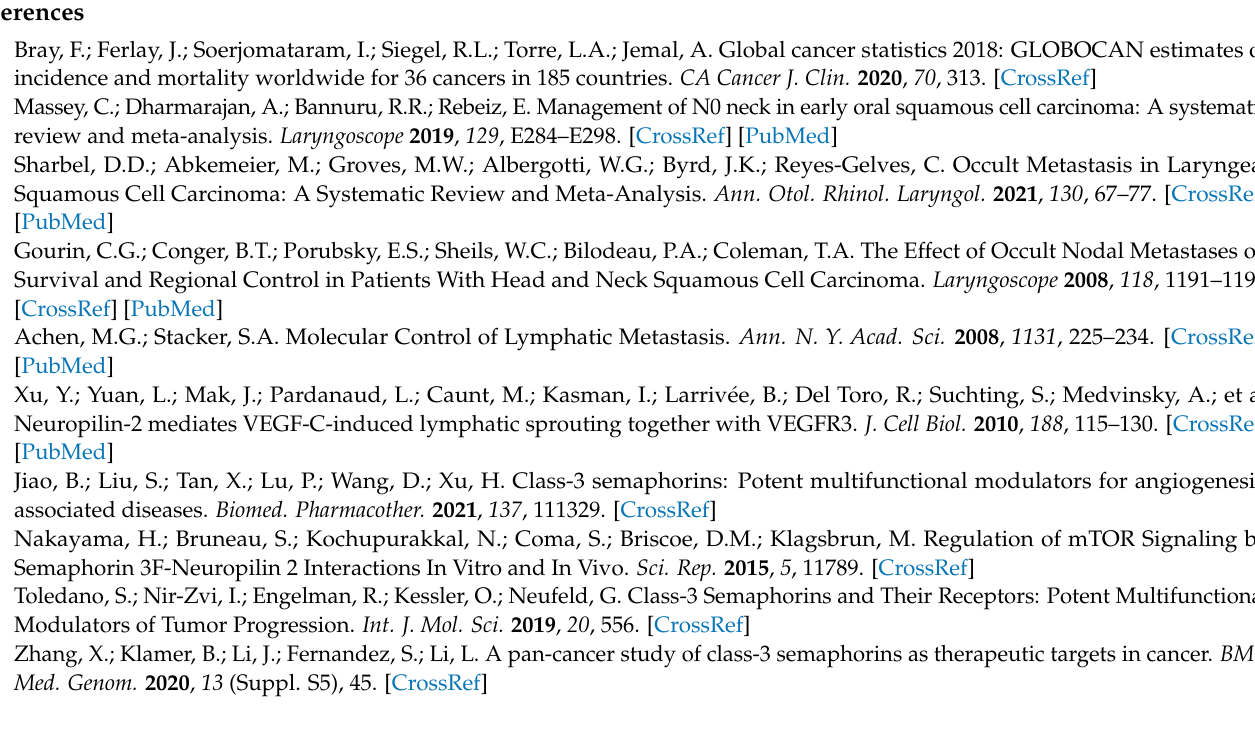
Figure S4: Distribution of the transcriptional expression values of NRP2 and SEMA3F in the samples of the healthy mucosa and the tumor of the patients included in The Cancer Genome Atlas; Table S1: Characteristics of the patients of The Cancer Genome Atlas included in the validation study; Table S2: Median of the transcriptional expression values of SEMA3F and NRP2 according to the characteristics of the patients included in the